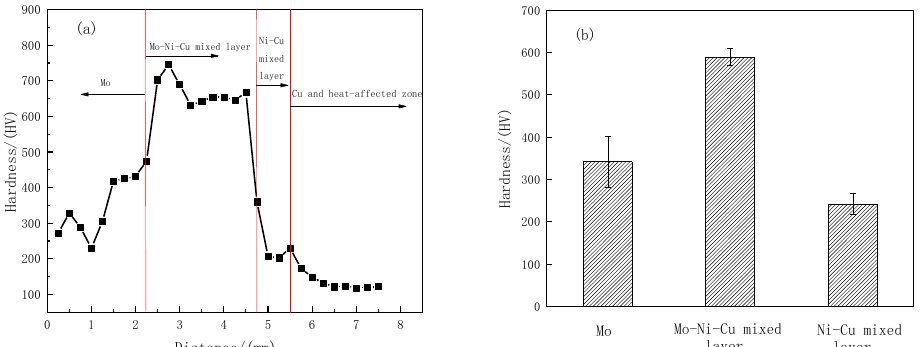
Figure 7. The hardness of the cladding layer: ( a ) the hardness distribution from the surface of the laser cladding to the substrate; ( b ) the average hardness of each layer.